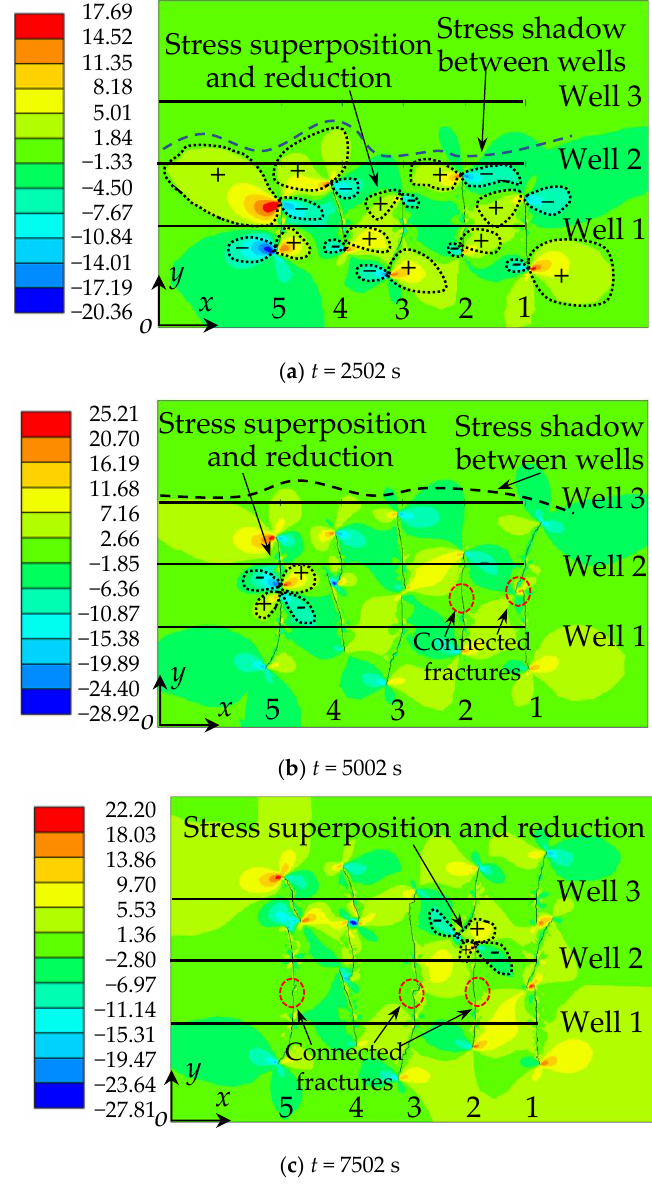
 (Mpa) in sequential fracturing at 75 m well spacing. Figure 10. Evolution of shear stress τ xy (Mpa) in sequential fracturing at 75 m well spacing. xy